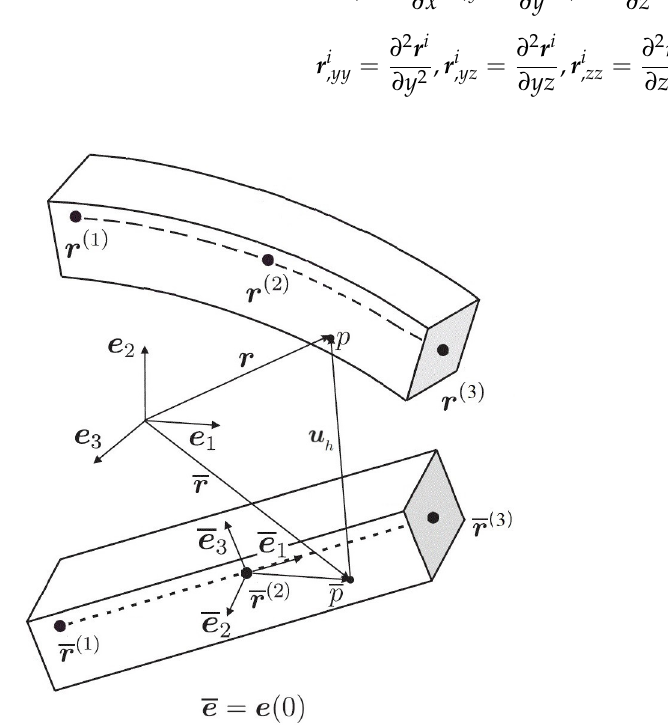
Figure 1. Illustration of a three-nodded beam element with an arbitrary particle p in current and p in reference configurations. The three nodes are denoted by r ( i ) and r ( i ) , respectively, i = 1,2,3